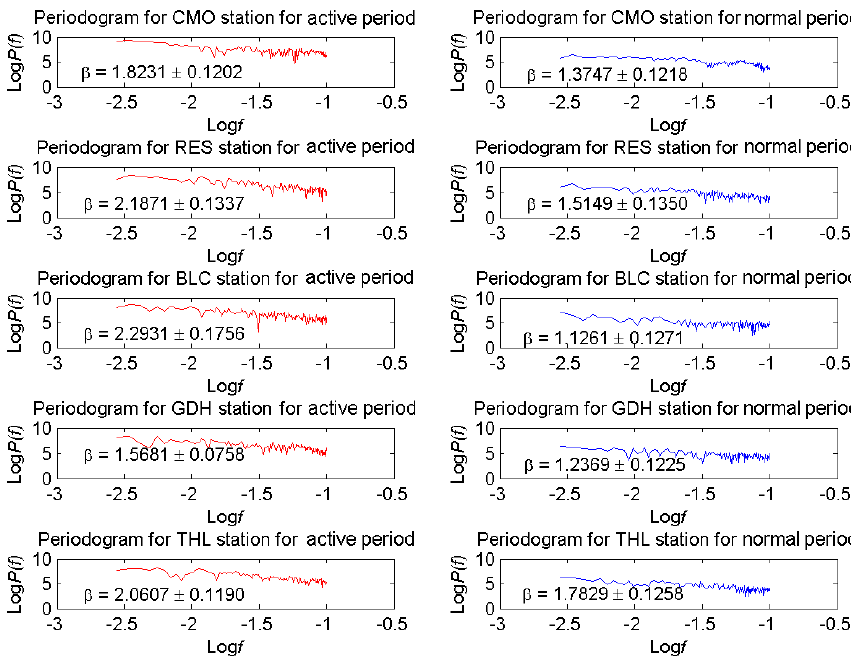
Figure 6. Periodogram for the high-latitude region during the active period and normal period. Table 3. The Hurst exponent as well as the maximum and minimum strength of the Earth’s magnetic field during the geomagnetic storm (active period) and normal periods for stations in the high-latitude region.